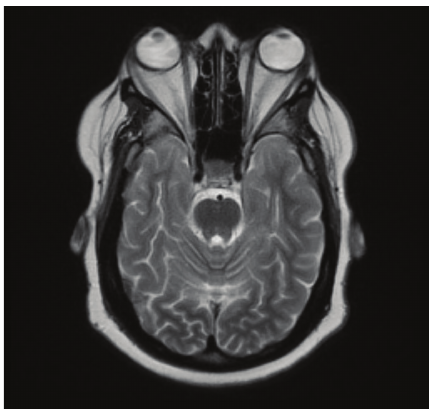
Figure 1: Bilateral exophthalmos as seen on MRI.